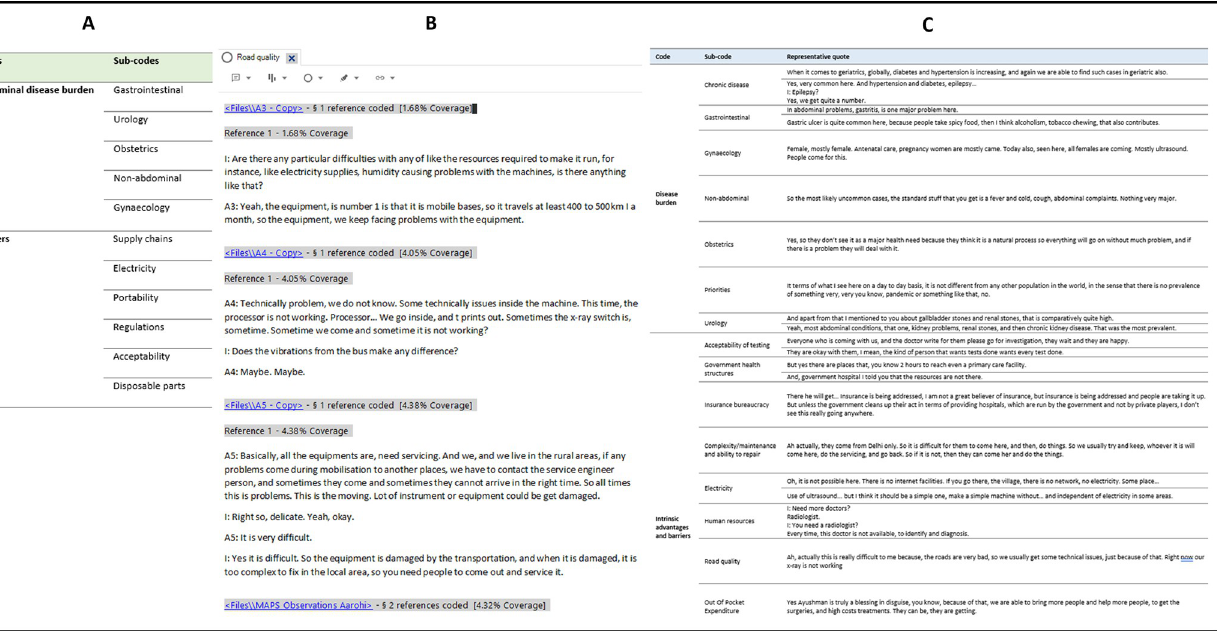
PLOS Global PublicHealth | https://doi.org/10.1371/journal.pgph.0001233 January6,